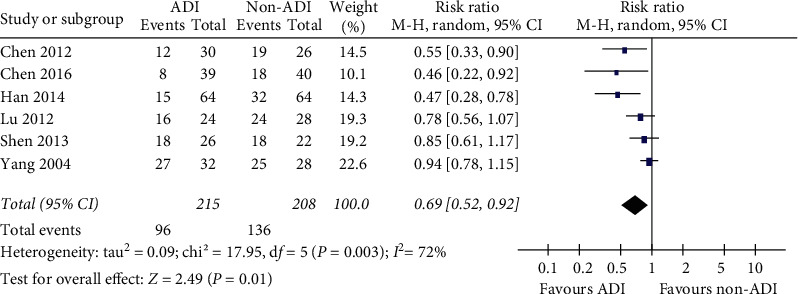
ADI decreased the numbers of myelosuppression in BC patients as an add-on therapy (RR = 0.69; 95% CI 0.52–0.92; I2 = 72%; P=0.003).